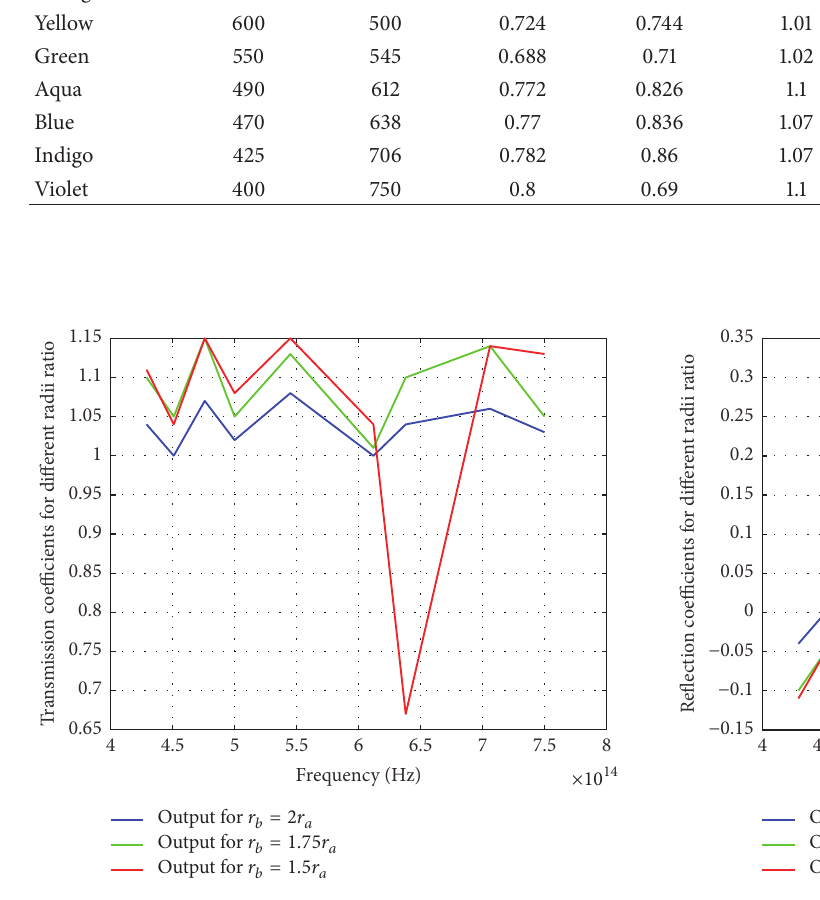
Figure 7: Plots for transmission coefficient versus frequency for different radii ratio.